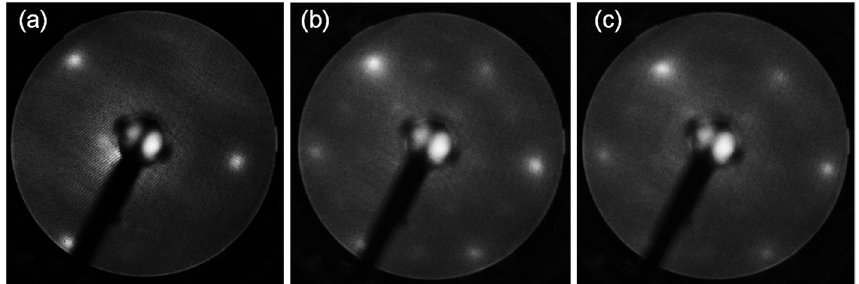
Figure 1. LEED patterns for the MgO(111) substrates ( a ) and magnetite: deposited with no field ( b ) and in-field ( c ). The electron energy is 100 eV.